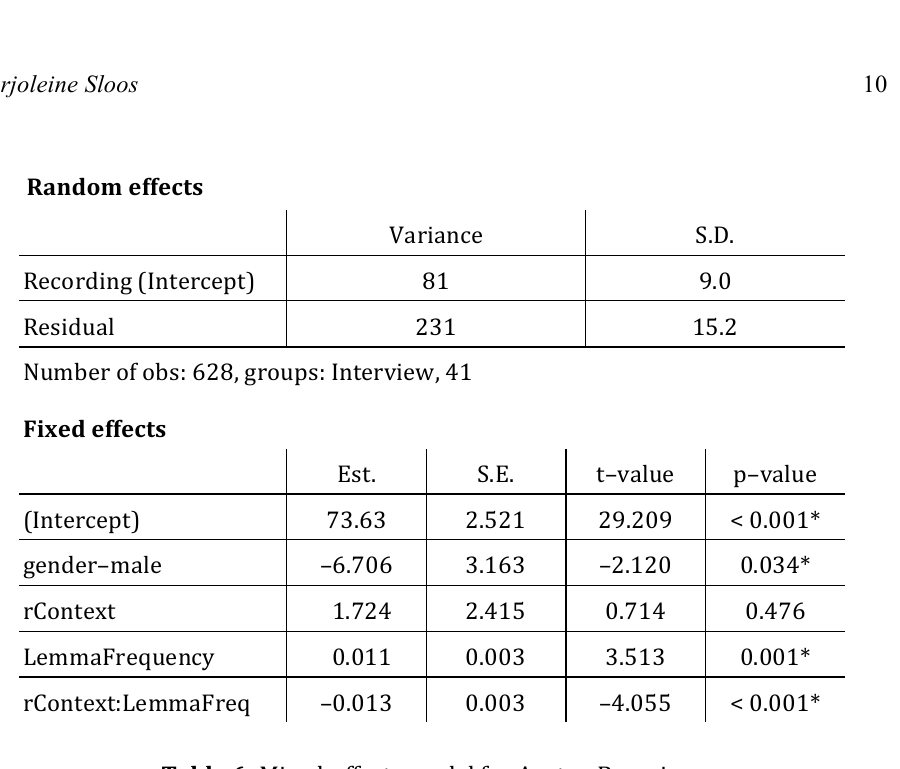
Table 6: Mixed-effects model for Austro-Bavarian